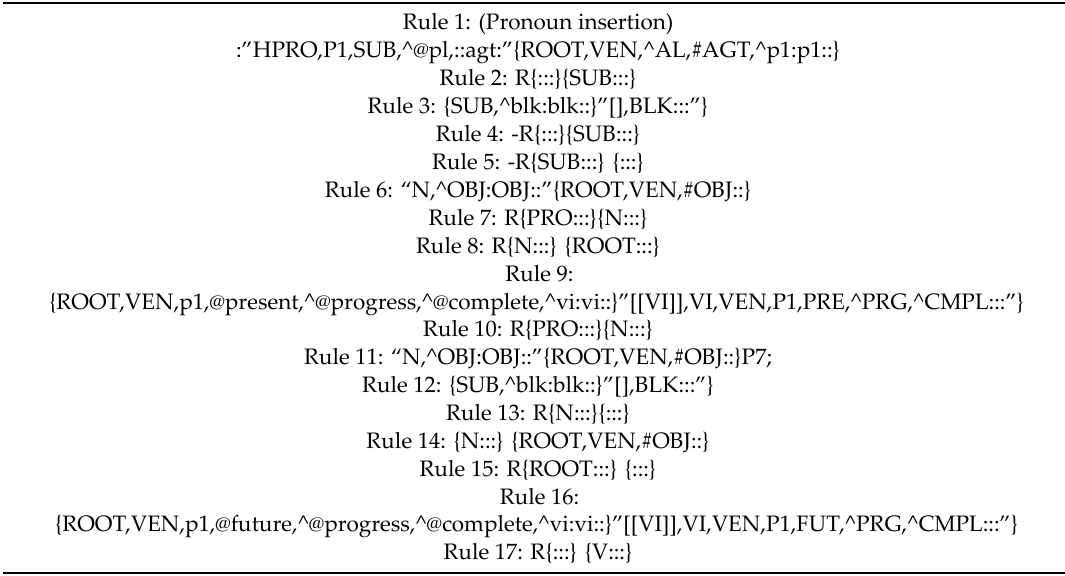
Table 2. Generation rules for extracting Bangla sentence from UNL